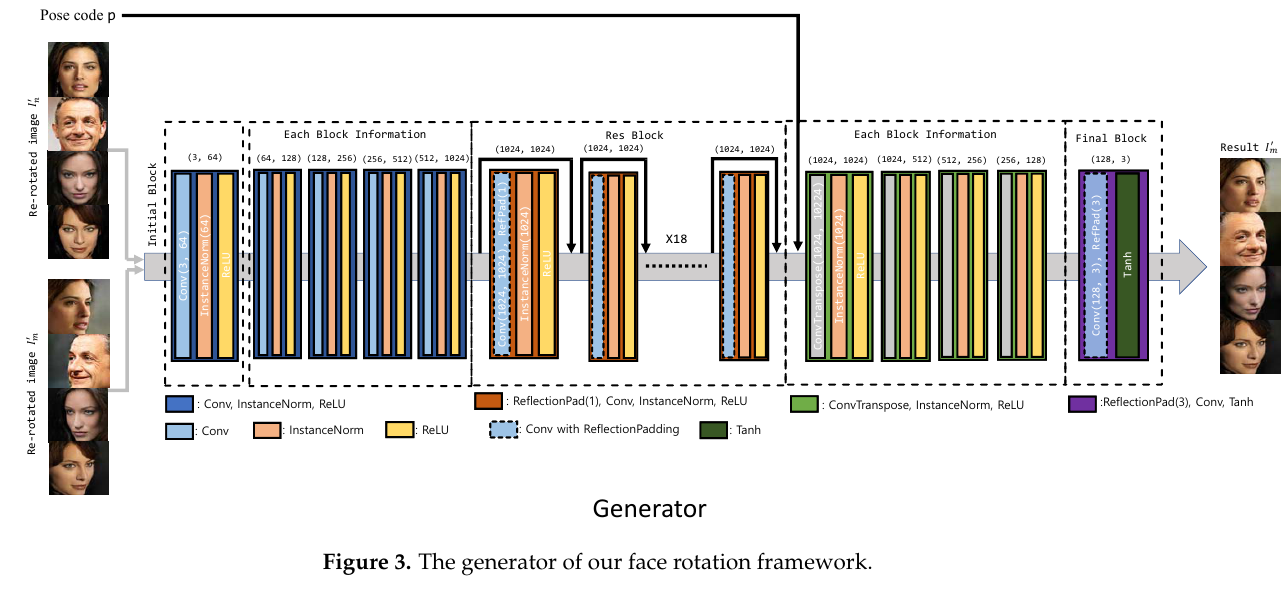
Figure 3. The generator of our face rotation framework.